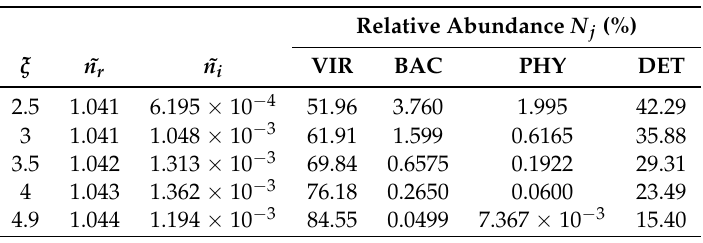
Table 4. Relative abundance of viruses (VIR), bacteria (BAC), phytoplankton (PHY), and organic detritus (DET) with the corresponding bulk refractive index (Equations (9) and (10)) for the water body with phytoplankton bloom conditions and no minerals (phytoplankton